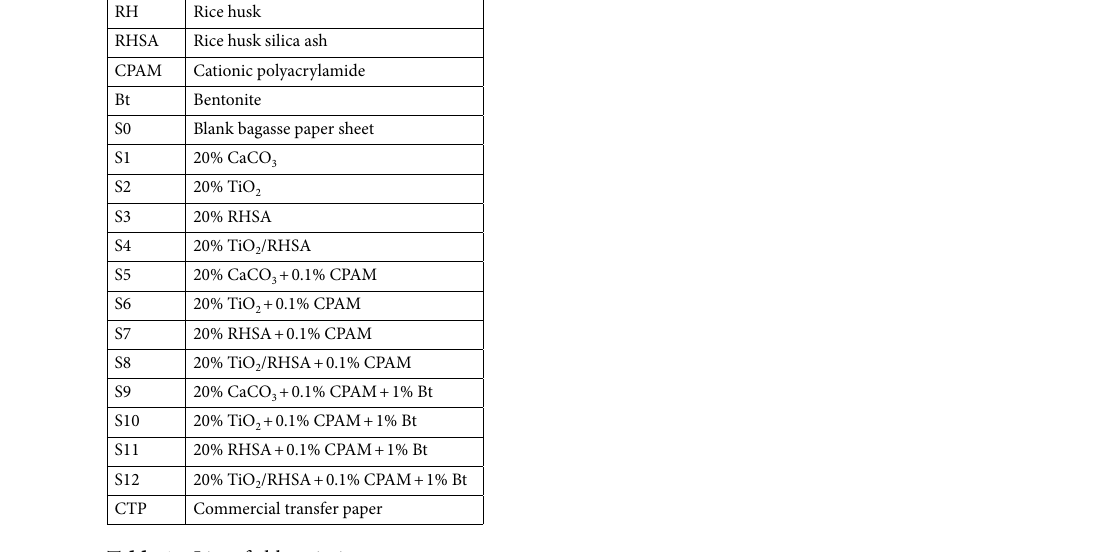
Table 1. List of